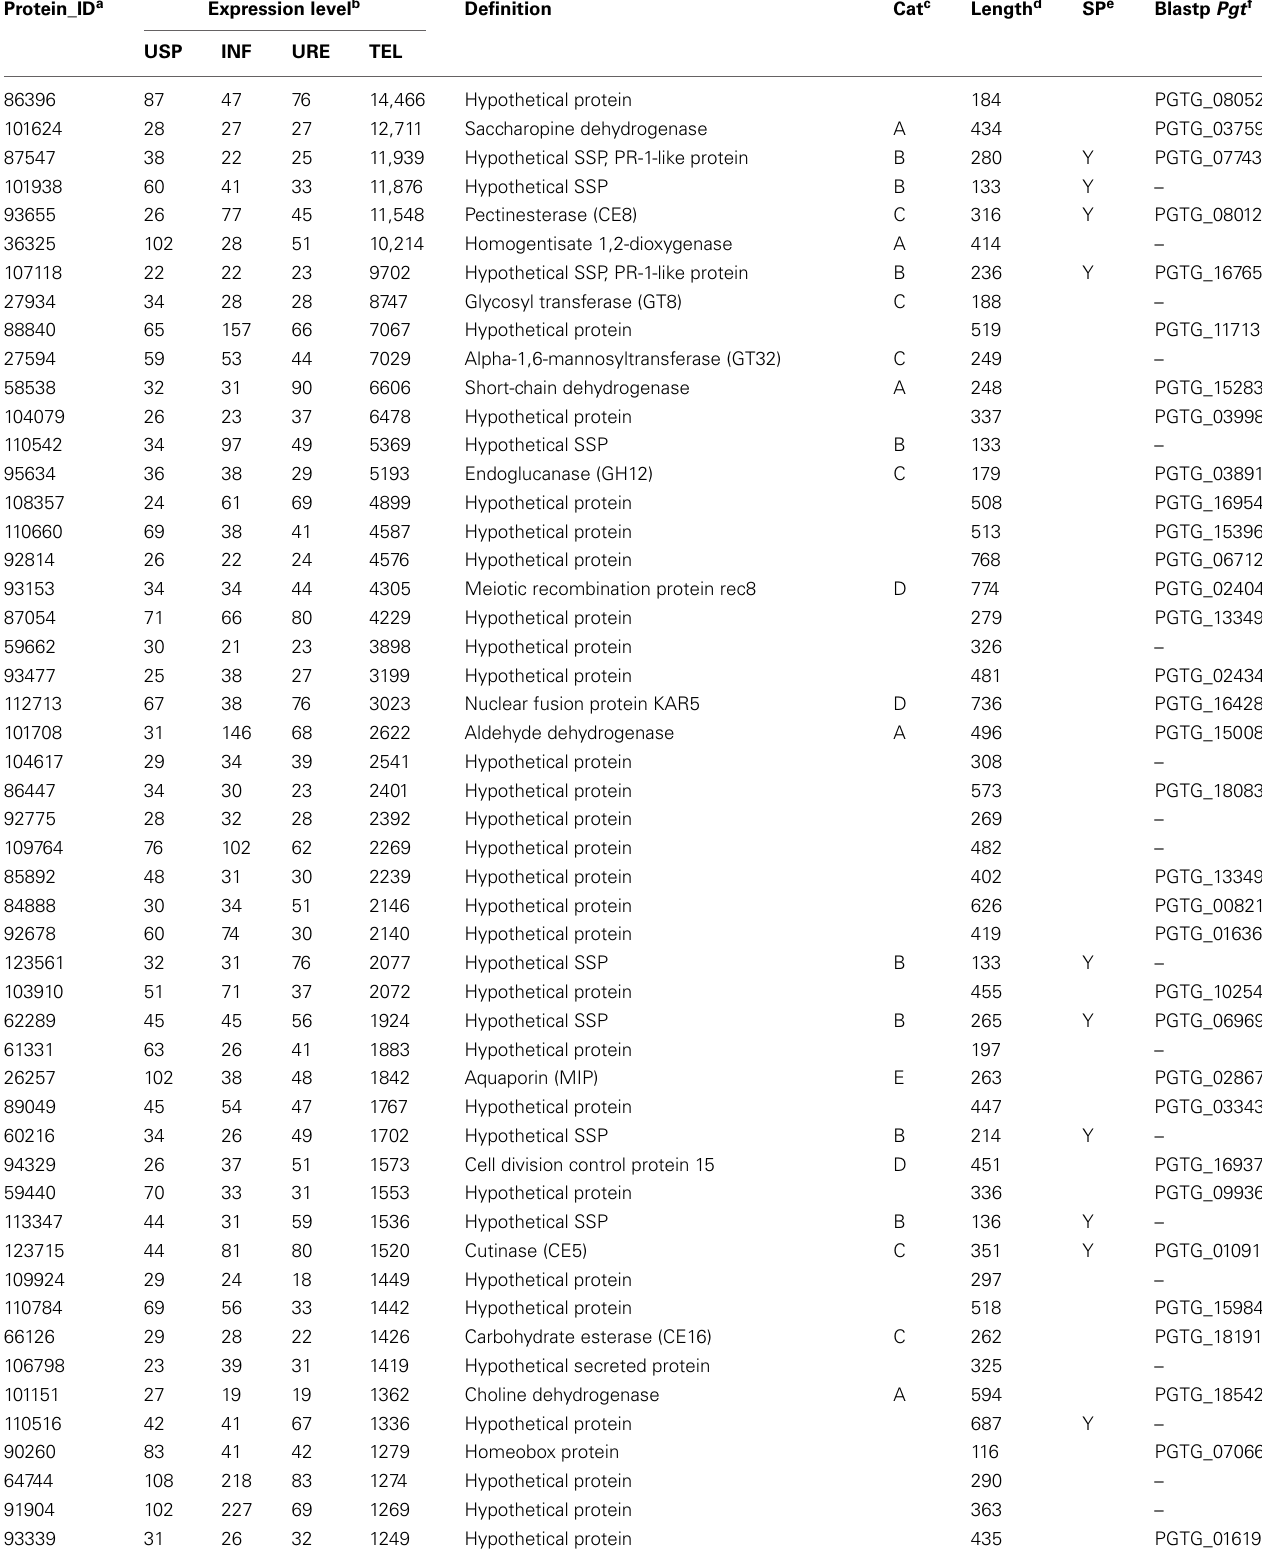
Table 1 | M. larici-populina genes highly and specifically expressed in telia. Protein_ID